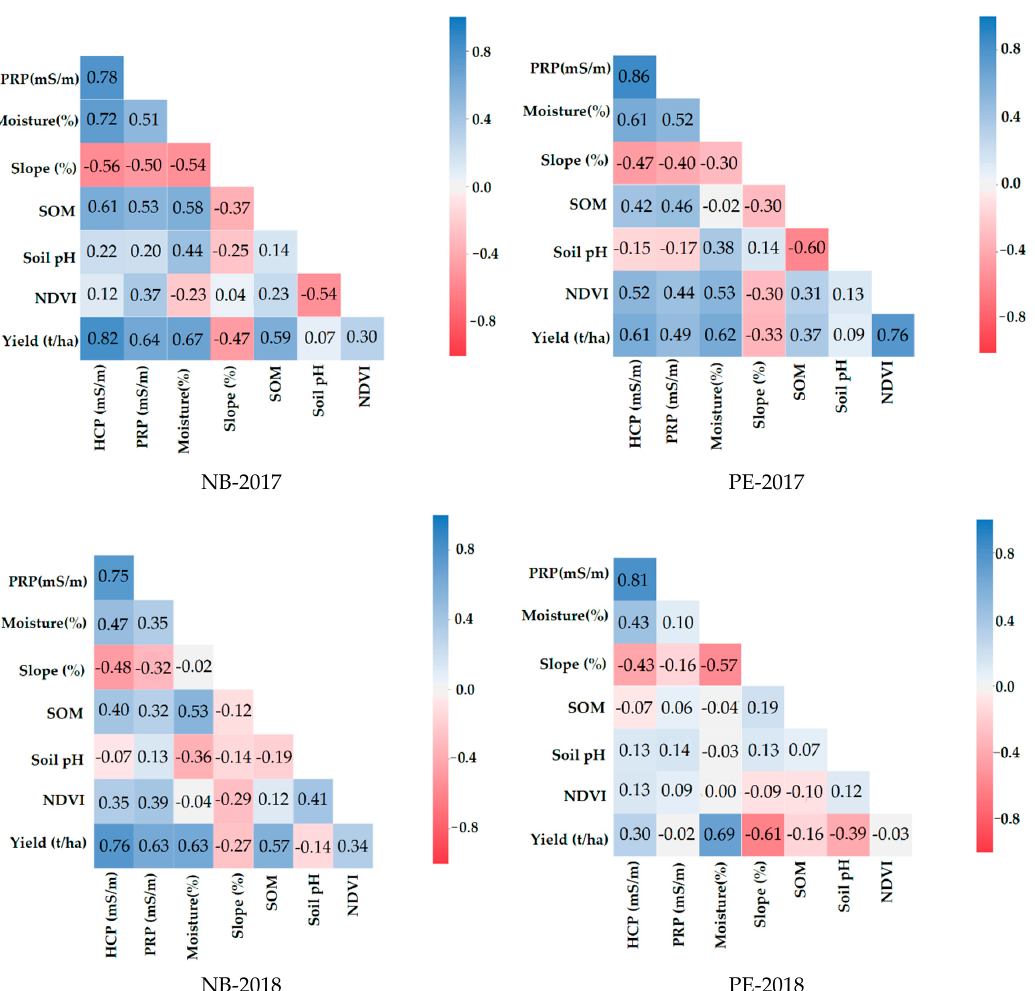
Figure 2. Pearson correlation analysis of selected variables for this study where all possible relationships within variables are presented. PRP is perpendicular/vertical coplanar geometry. HCP is horizontal coplanar geometry. SOM is soil organic matter (%). NDVI is normalized difference vegetation index.